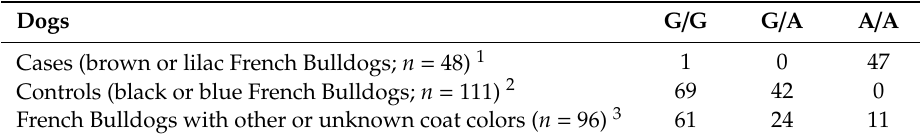
Table 2. Genotype–phenotype association of the HPS3 :c.2420G > A variant in dogs with at least one wildtype TYRP1 allele ( TYRP1 B / - ). Detailed information on all phenotypes and genotypes of all 373 studied dogs are listed in Table